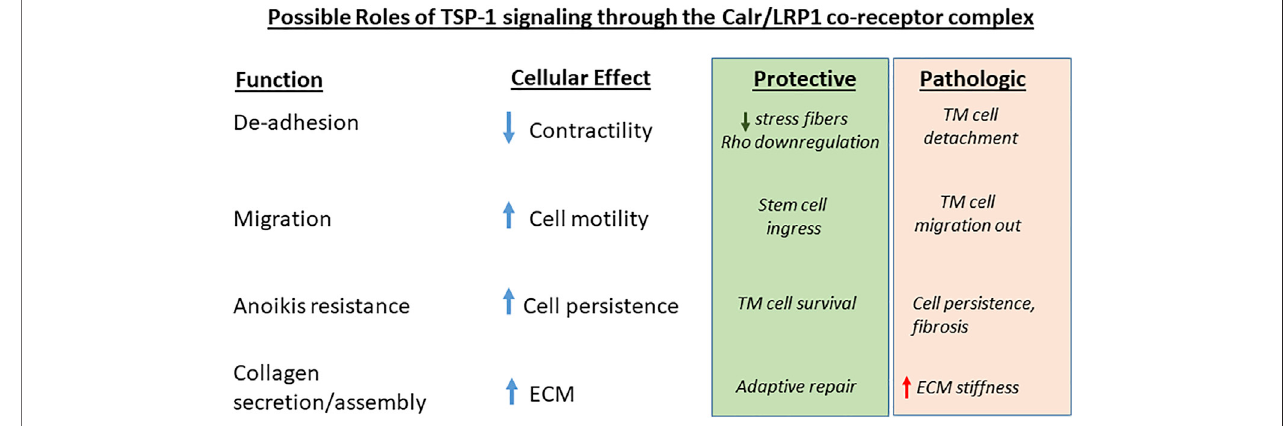
FIGURE 3 | Possible roles of TSP-1/Calr/LRP1 signaling in glaucoma. The four major functions ascribed to TSP-1 signaling through the Calr/LRP1 receptor co- complexandtheircellulareffectsaredesignated.Potentialbene fi cialorpathologiceffectsoftheseactivitiesinglaucomacellresponsestoinjuryandECMremodelingare